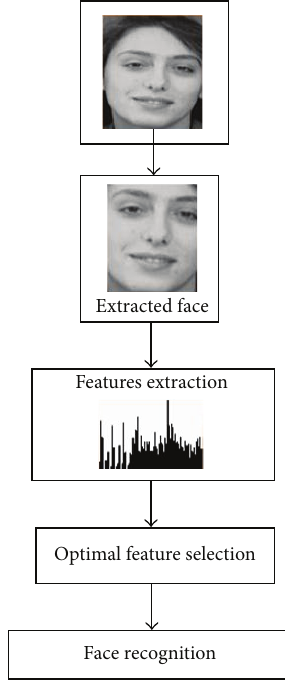
Figure 1: The proposed system